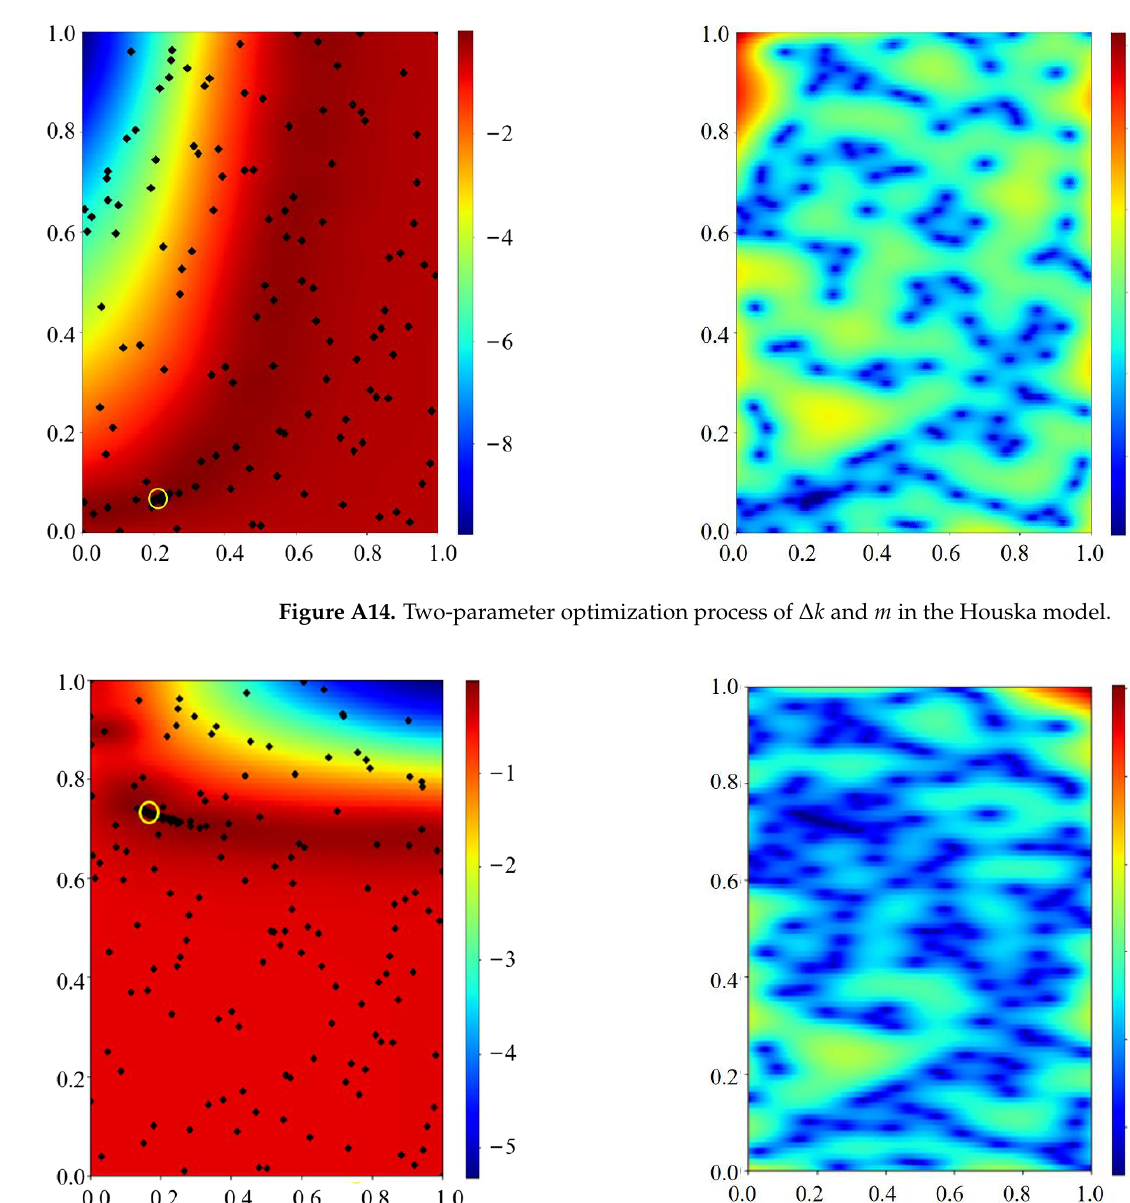
Figure A15. Two-parameter optimization process of 𝛥 and 2 in the Teng model.